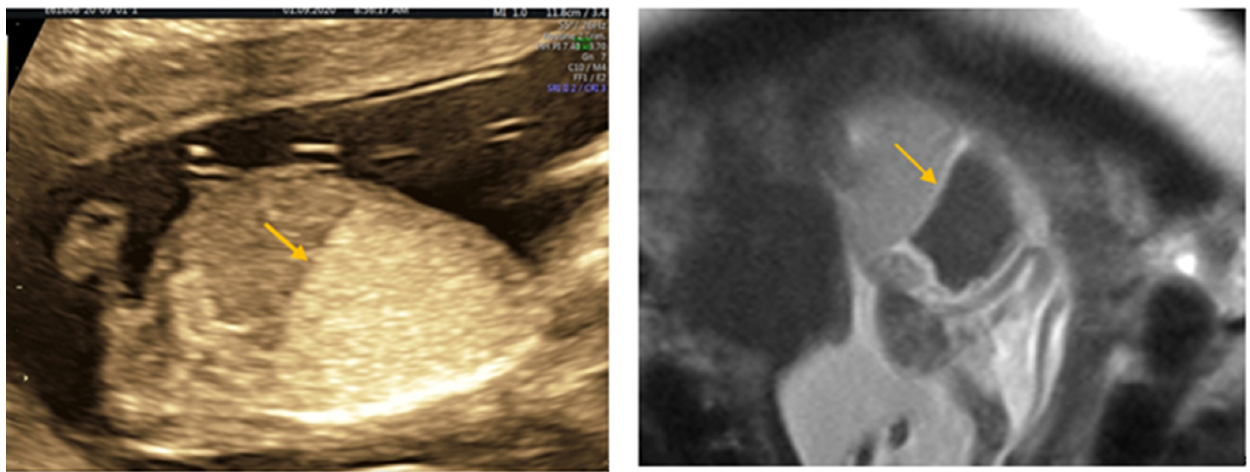
Figure 3. Inverted Diaphragm on ultrasound scan and on RMI (arrow).